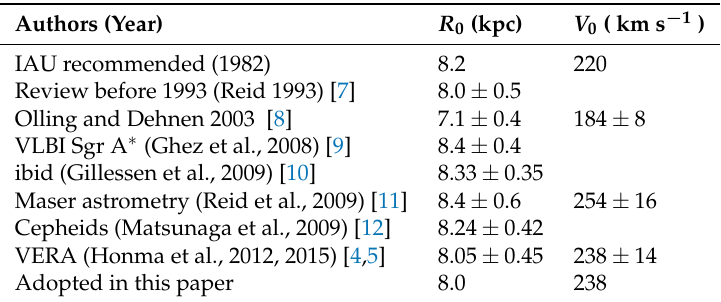
Table 1. Galactic constants ( R 0 , V 0 ).